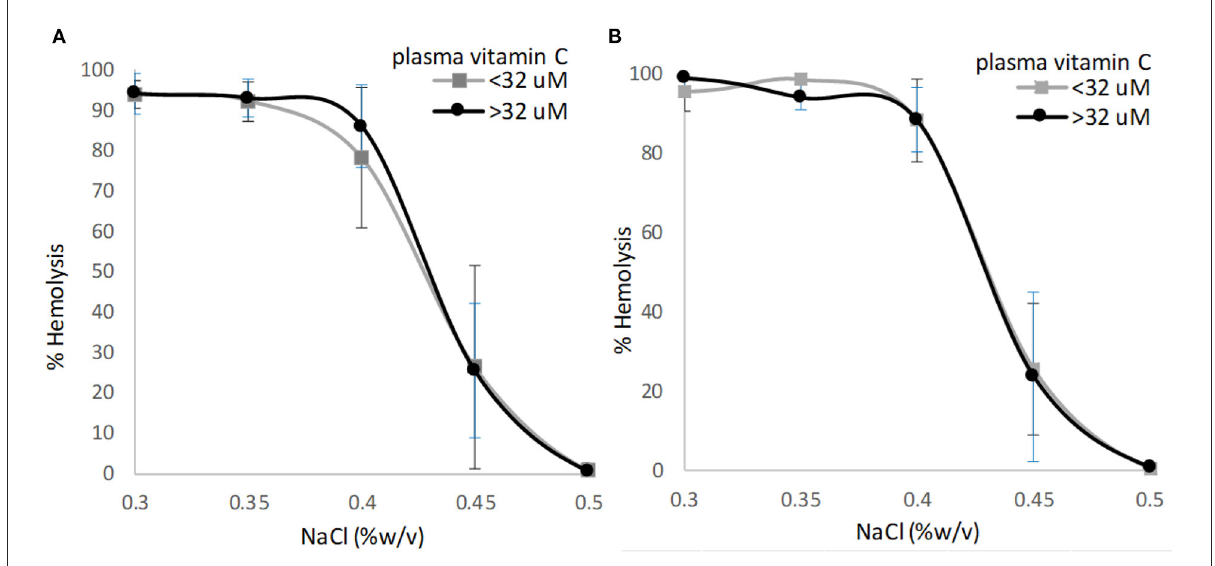
FIGURE2 Osmotic erythrocyte fragility as a function of plasma vitamin C nutriture using the sample median (32 µ M) as the cutoff. (A) Individuals with type 2 diabetes, p = 0.532; (B) Individuals with no diabetes, p = 0.170. Data points are mean ± SD; p -value represents multivariate analysis controlling for age and BMI.